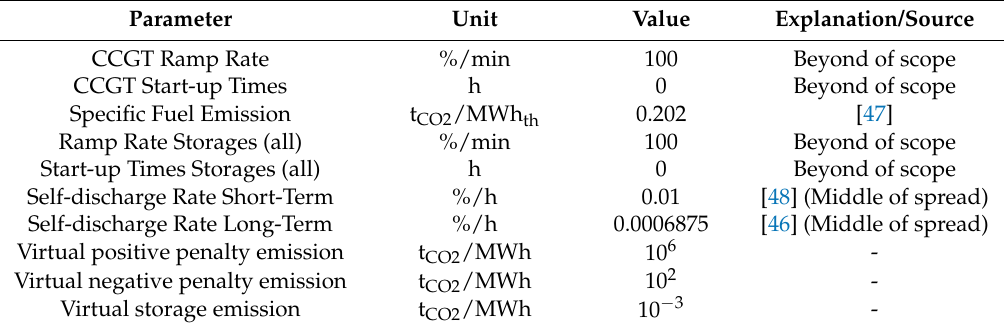
Table A2. Additional parameters used in the simulation.